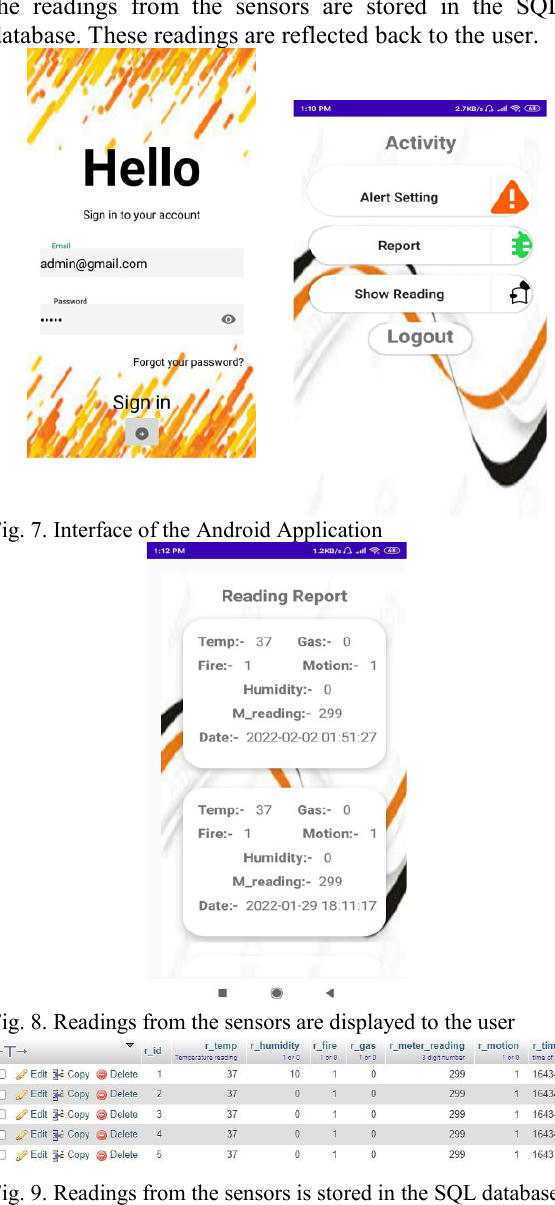
Fig. 9. Readings from the sensors is stored in the SQL database